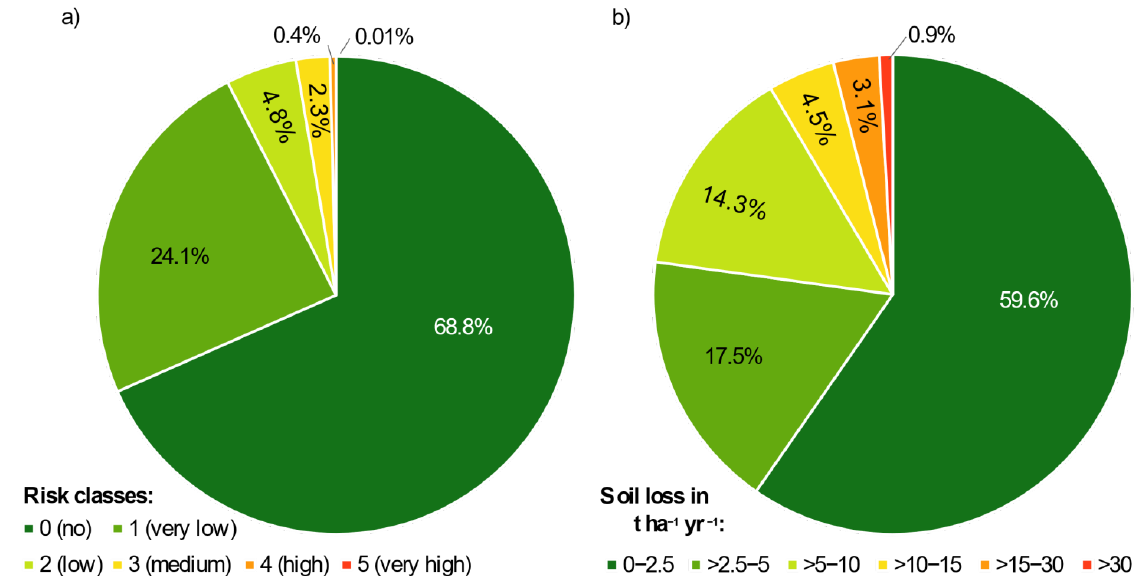
Figure 6. Distribution of ( a ) risk classes assessed by DIN 19706 and ( b ) wind erosion soil loss in t ha −1 yr −1 per soil loss class modeled with the revised wind erosion equation (RWEQ).